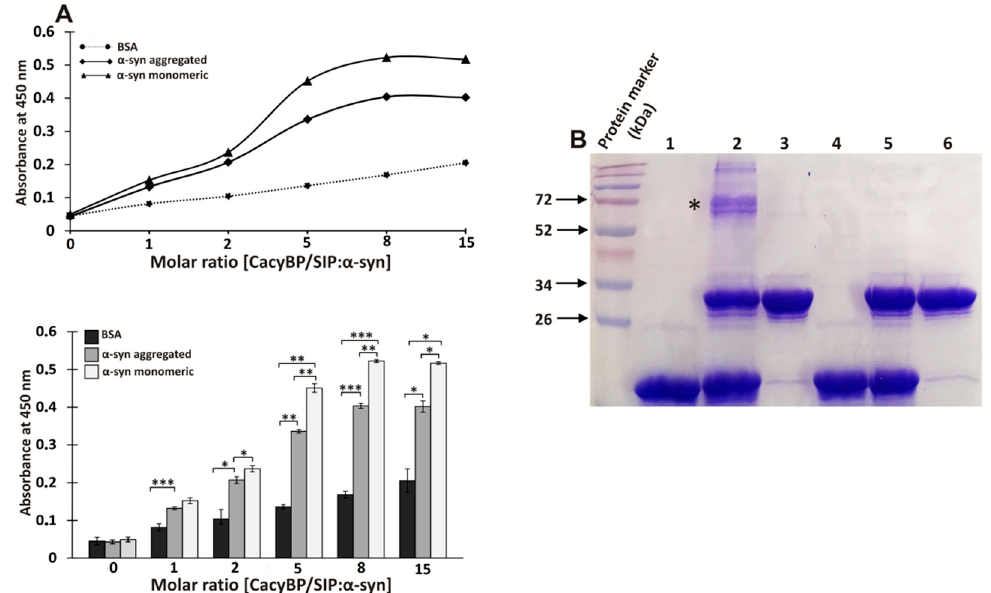
Figure 6. Interaction between α -synuclein and CacyBP / SIP studied by ELISA ( A ) and chemical crosslinking ( B ). ( A ) Upper panel shows absorbance measured at di ff erent molar ratio of CacyBP / SIP (concentration 0, 3.89, 7.78, 19.45, 31.12, and 58.35 µ M) to α -synuclein (3.89 µ M) while the lower one